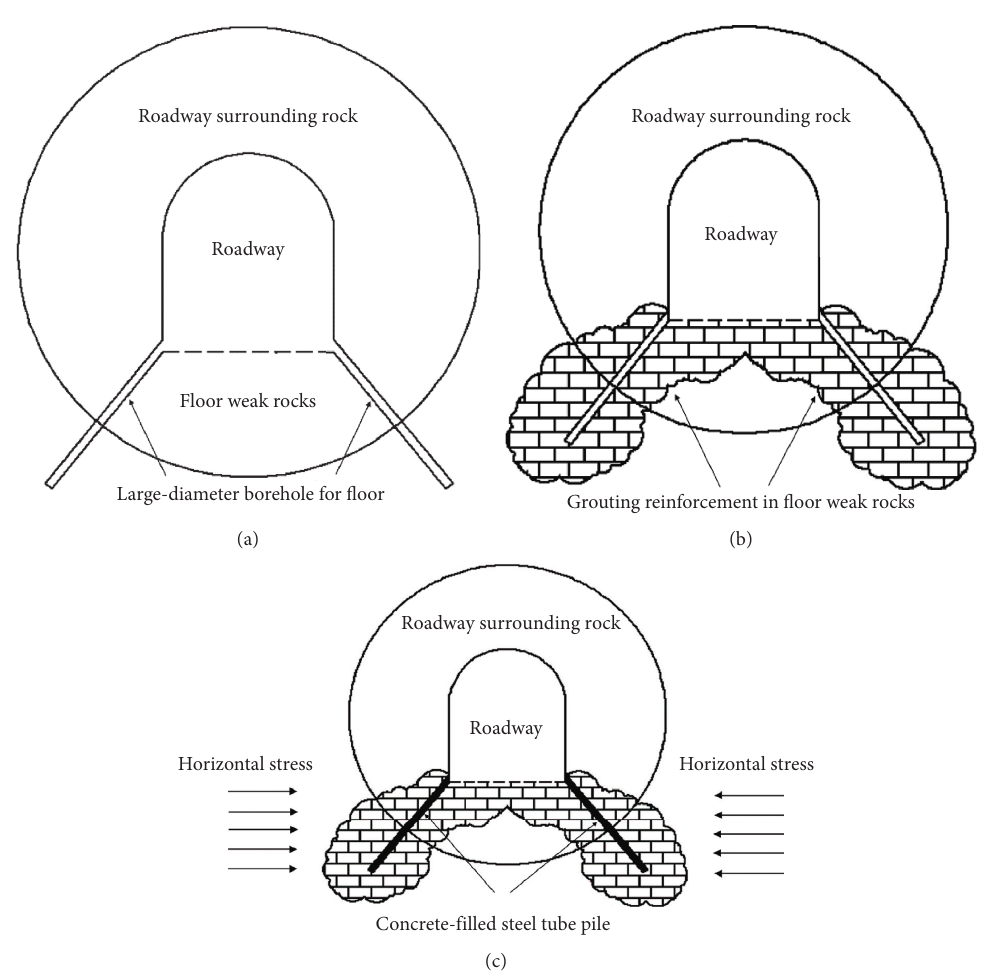
Figure 6: Pressure relief and stress resistance technology in roadway floor. (a) The large-diameter borehole pressure relief. (b) Grouting reinforcement technique. (c) Floor corner pile stress resistance.